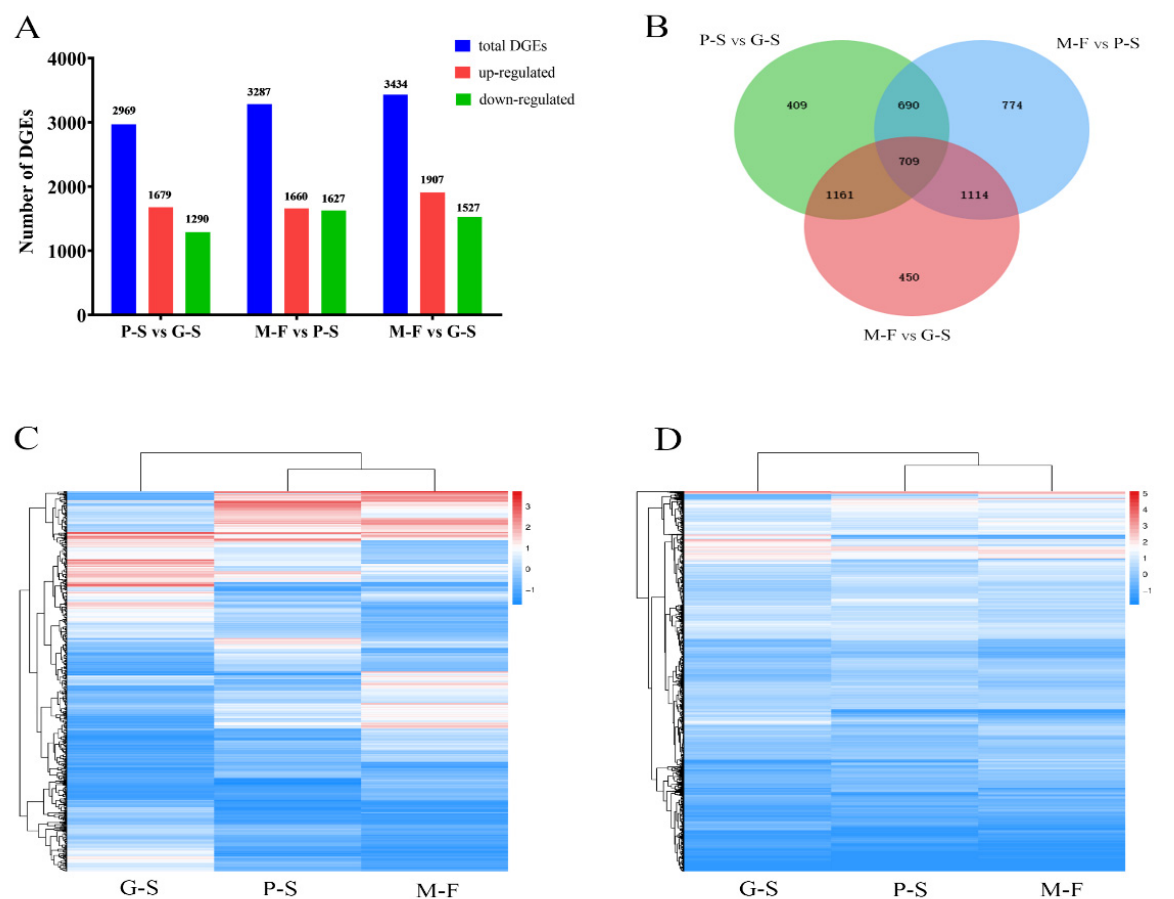
Figure 2. Analysis of DEGs at different growth and development stages. ( A ) DEG distribution between the two samples analyzed. The number of DEGs is indicated at the top of the histograms. ( B ) Venn diagrams comparing shared DEGs among the different growth stages. ( C ) Expression patterns of the 709 genes that overlap between P-S vs. G-S, M-F vs. P-S and M-F vs. G-S. ( D ) Gene expression levels in different growth and development stages.